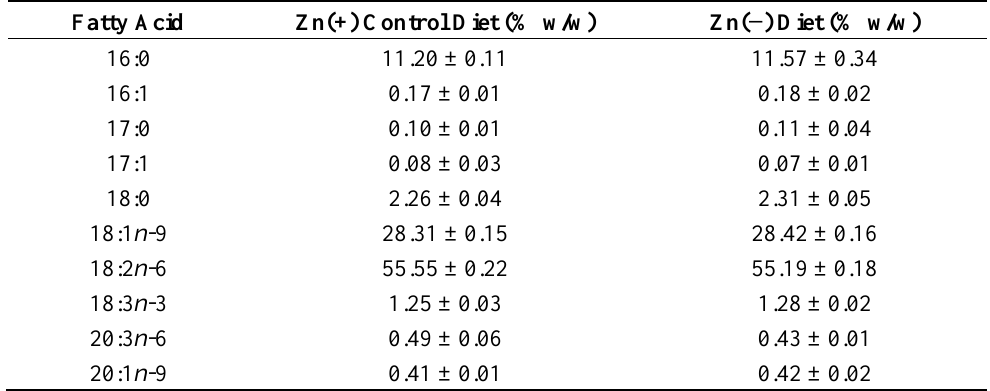
Table 2. Fatty acid composition of the Zn(+) control and Zn(−) diets * ,